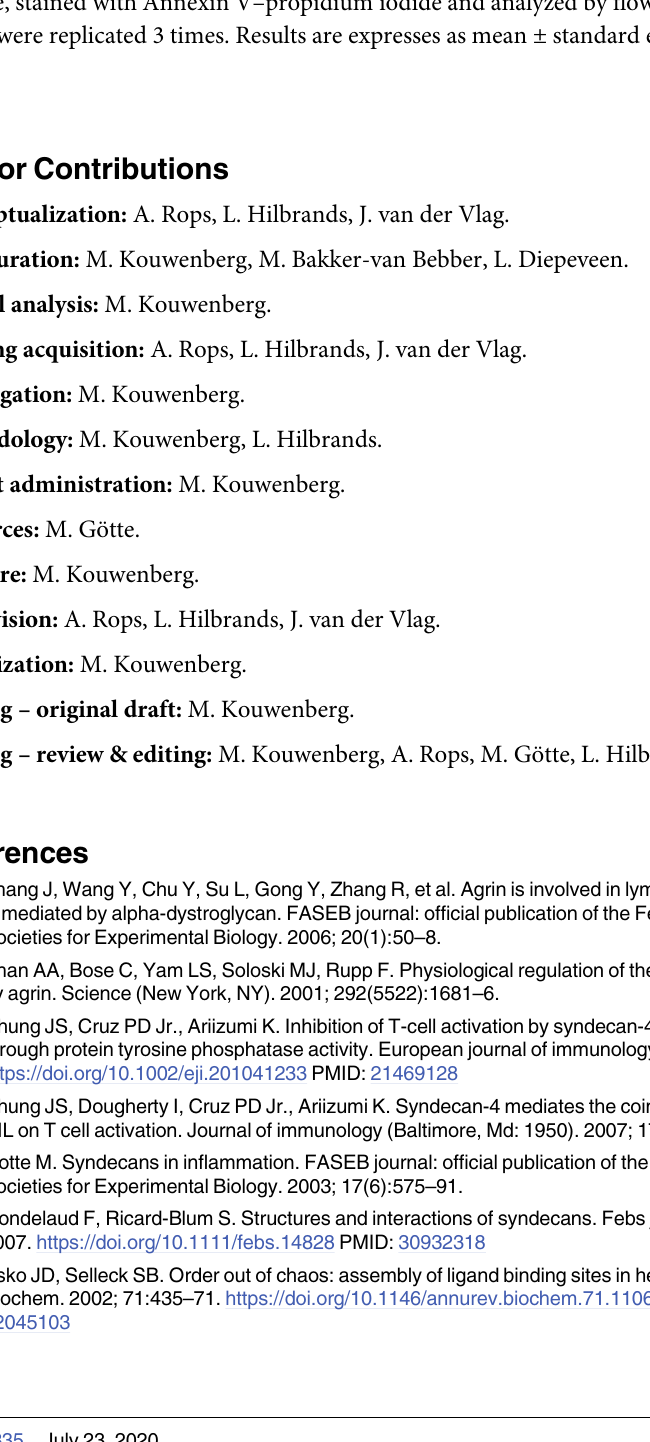
S2 Fig. Splenocyte composition is not altered in Sdc-1 deficient mice. Splenocytes of Sdc-1 deficient and WT mice were analyzed for expression of CD3, CD4, CD8 and CD19 by flow cytometry. Experiments were replicated 5 times. Results are expresses as mean ± standard error of means. S3 Fig. Sdc-1 splenocytes are not more susceptible to 4-nitroquinoline 1-oxide induced apoptosis. Sdc-1 deficient or WT splenocytes were incubated with low dose 4-nitroquinoline 1-oxide, stained with Annexin V–propidium iodide and analyzed by flow cytometry. Experi- ments were replicated 3 times. Results are expresses as mean ± standard error of